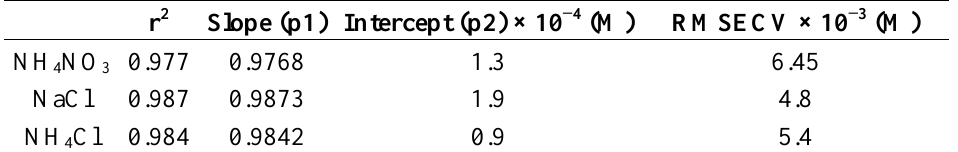
Table 4. Parameters from the linear fitting of prediction data from the PLS analysis using Pt, Co, Cu and Ni